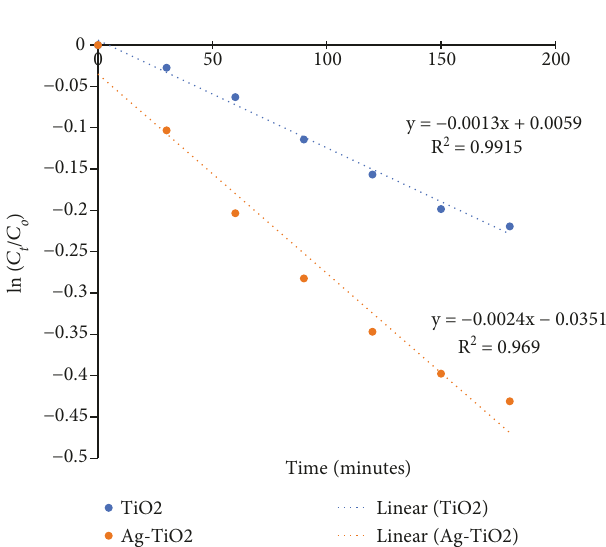
/ C Figure 6: C t o vs time under UV light irradiation, where to the concentration at time t of MB and C o refers to initial concentration.